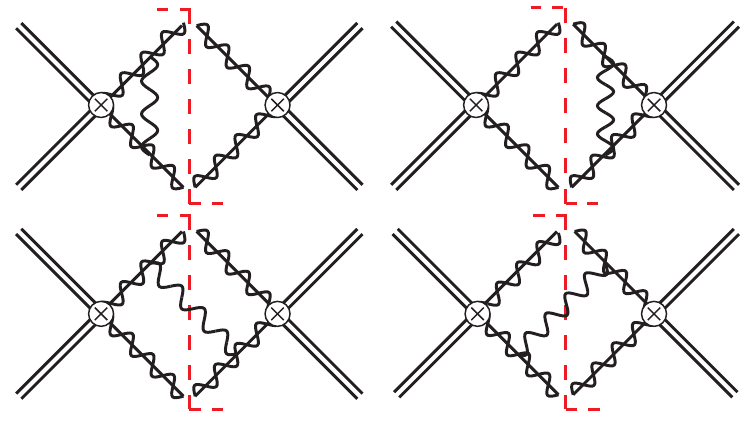
Figure 12 . The four possible cuts through the n